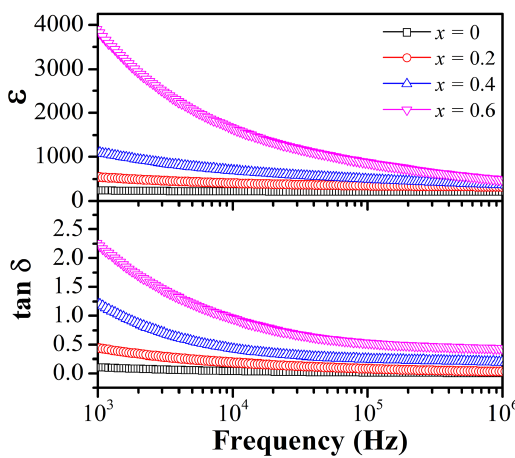
Figure 5. Frequency dependence of dielectric constant (ɛ) and loss (tan δ) of single-phase Ca